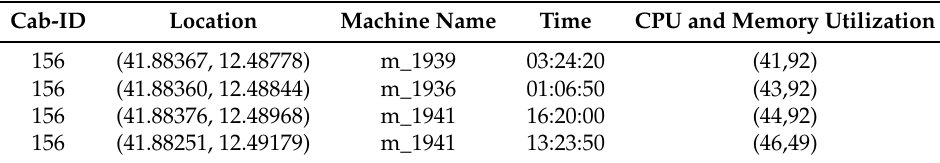
Table 1. A sample of the data set in the random mapping.